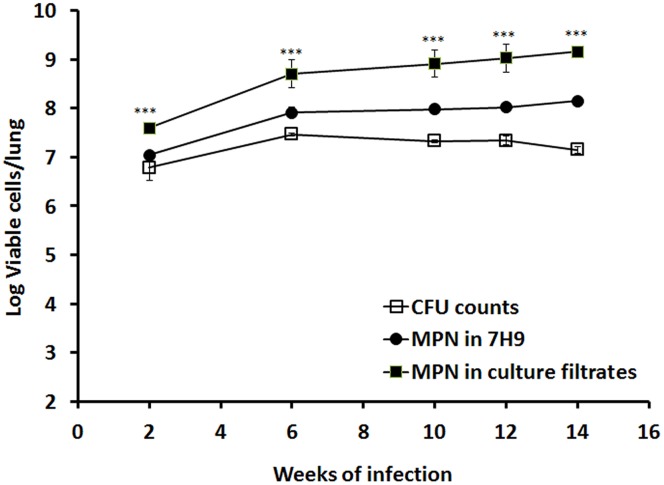
Resuscitation of M. tuberculosis grown in mouse lungs. BALB/c mice were infected with M. tuberculosis. Viability of the bacilli in lung was determined by CFU counting and MPN counting with 7H9 or the culture filtrates at 2, 6, 10, 12, and 14 weeks post-infection. The results have been performed twice with reproducible results. ANOVA analysis demonstrated that there were significant differences amongst CFU counts, 7H9 broth counts and RPF broth counts (∗∗∗P < 0.001) in mice.